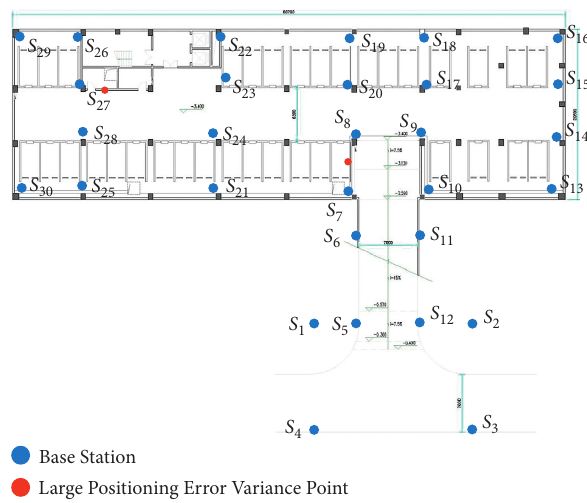
Figure 10: Point distribution with large positioning error